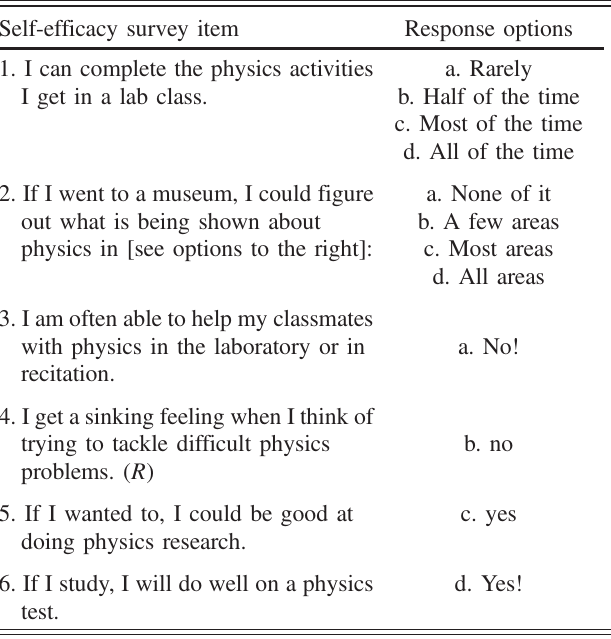
TABLE I. The physics self-efficacy survey with response options. One item in the survey is reverse coded and indicated as ( R